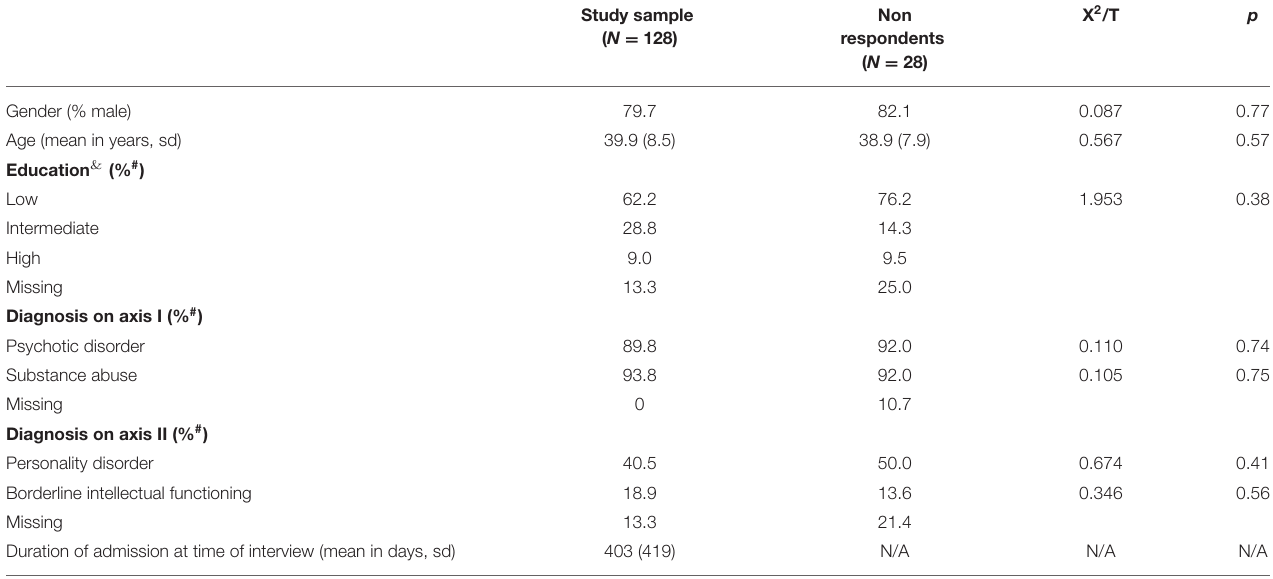
TABLE 1 | Demographic and clinical characteristics of dual diagnosis patients admitted to SuRe.